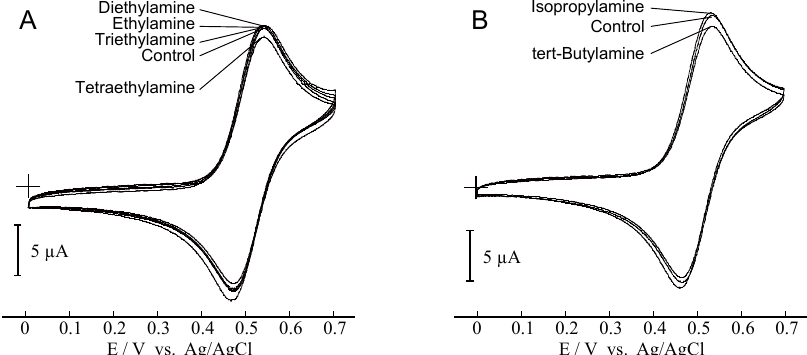
Figure 6. Cyclic voltammograms of TEMPO (1 mM) in the absence and presence of 10 mM ( A ) ethylamine, diethylamine, triethylamine, and tetraethylammonium, and ( B ) isopropylamine and tert - butylamine in 100 mM phosphate buffer solution (pH 7.4). Scan rate was 100 mV s − 1 .